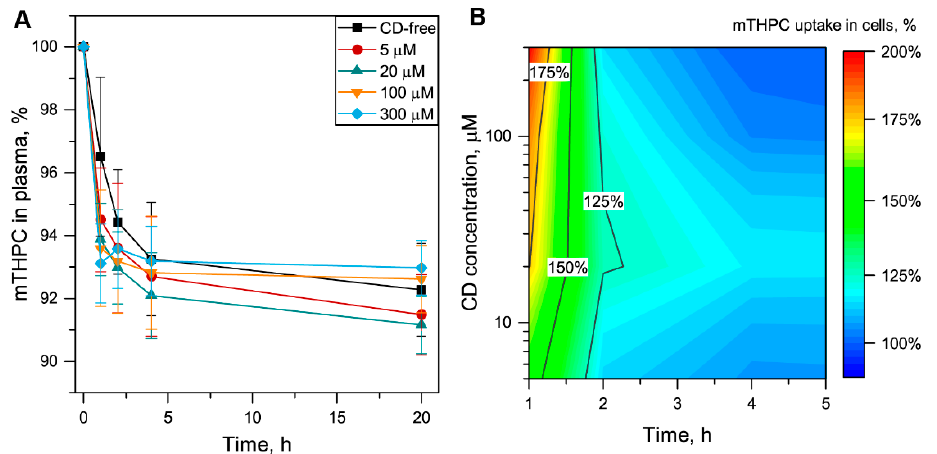
Figure 4. Redistribution of mTHPC from plasma to the blood cells in the presence of Me- β -CD. ( A ) Kinetics of mTHPC redistribution from plasma to the blood cells in the absence of Me- β -CD ( ■ ) and in the presence of 5 µM ( ● ), 20 µM ( ▲ ), 100 µM ( ▼ ), and 300 µM ( ♦ ) of Me- β -CD. Graphs represent the mean ± SD ( n = 3). ( B ) The 2D contour plots of mTHPC uptake in blood cells in the function of time and concentration of Me- β -CD. Uptake of mTHPC in the absence of Me- β -CD was taken as 100%. The concentration of mTHPC was 4.5 µM.